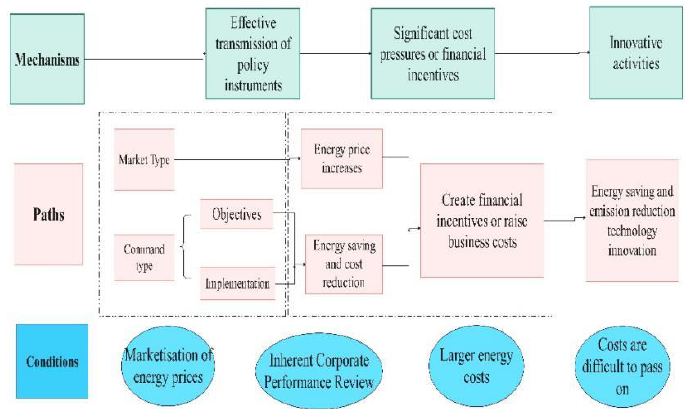
Figure 1. Mechanisms of action of market-based and command-based policy instruments to induce eco-innovation.